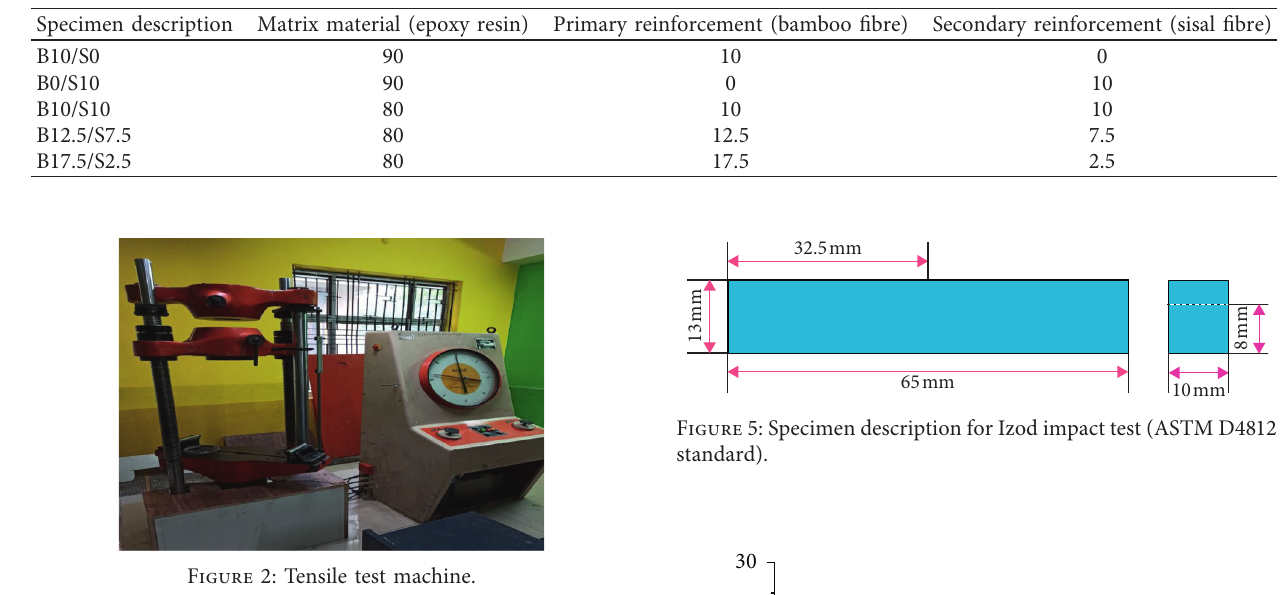
Table 1: Weight percentages of matrix and reinforcement materials.